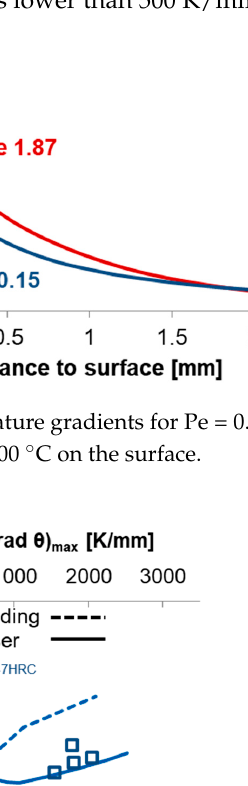
Figure 15. Temperature gradients for Pe = 0.15 (blue) and Pe = 1.86 (red) during the heating period at approximately 800 °C on the surface.